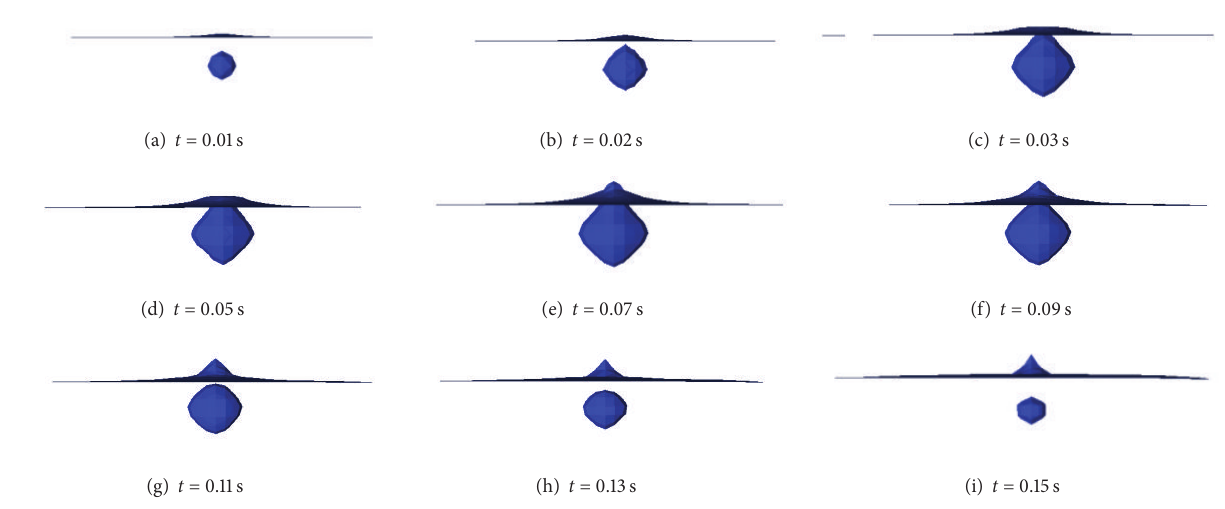
Figure 8: Calculated evolution of the bubble at 0.3 kg detonation at a depth d =